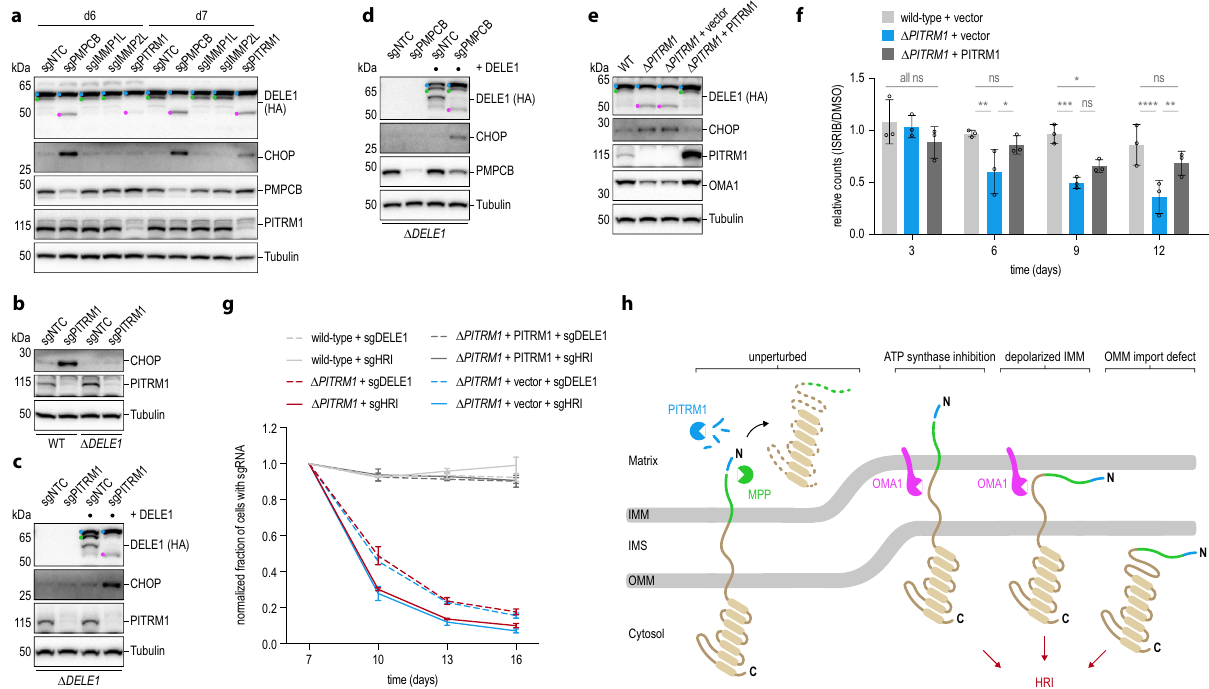
Fig. 7 Mitochondrial stress induced by de fi ciencies in MPP or PITRM1 imposes a cytoprotective state of ISR signaling via DELE1. a HeLa DELE1 HA cells exposed to the speci fi ed sgRNAs or a non-targeting control (NTC). DELE1 processing and CHOP induction analyzed by immunoblotting as indicated. b HeLa WT and Δ DELE1 cells were transiently exposed to an sgRNA directed against PITRM1 (or NTC sgRNA) and induction of CHOP was analyzed by immunoblotting seven days post-transfection. c , d HAP1 DELE1 knockout ( Δ DELE1 ) or stably reconstituted cells were infected with lentivirus encoding a NTC sgRNA or sgRNAs targeting PITRM1 ( c ) or PMPCB ( d ). CHOP levels were analyzed by immunoblotting seven ( c ) or six ( d ) days post transduction. ( e ) HeLa DELE1 HA WT, clonal PITRM1 knockout cells ( Δ PITRM1 ) and clonal PITRM1 knockout cells reconstituted with PITRM1 or empty vector ( Δ PITRM1 + PITRM1/ vector) were analyzed for DELE1 cleavage and CHOP levels by immunoblotting. f HeLa DELE1 HA cells of the indicated genotypes were cultured in